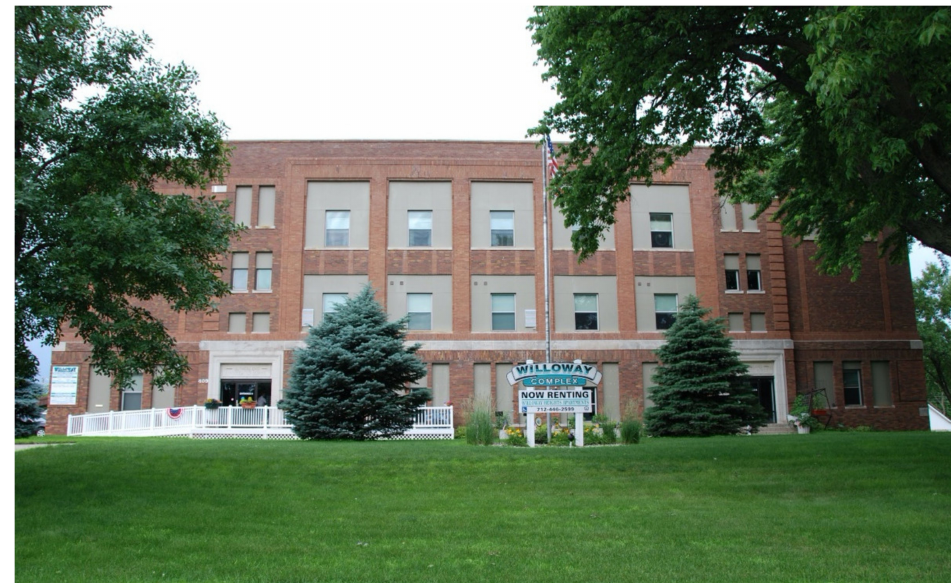
Figure 8. From transect across Northwest Iowa: Stage 4–Recycling. Willoway in Sutherland.